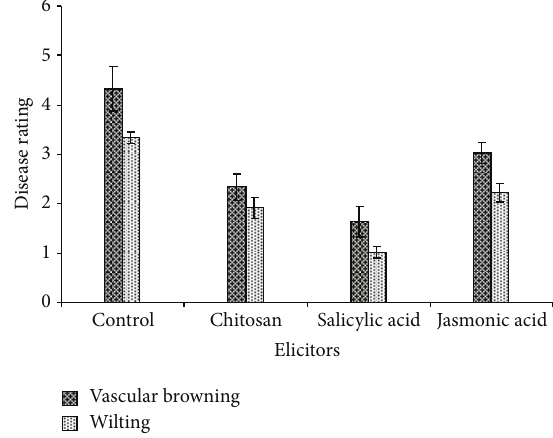
Figure 8: Induction of resistance in tomato plants against Ralstonia solanacearum infection by elicitors. Data on vascular browning of roots and leaf yellowing wilting were recorded 4 weeks after challenge of tomato plants by Ralstonia solanacearum . Columns represent the mean disease rating on a 1–5 scale as described in Section 2. The experiments were repeated three times with three